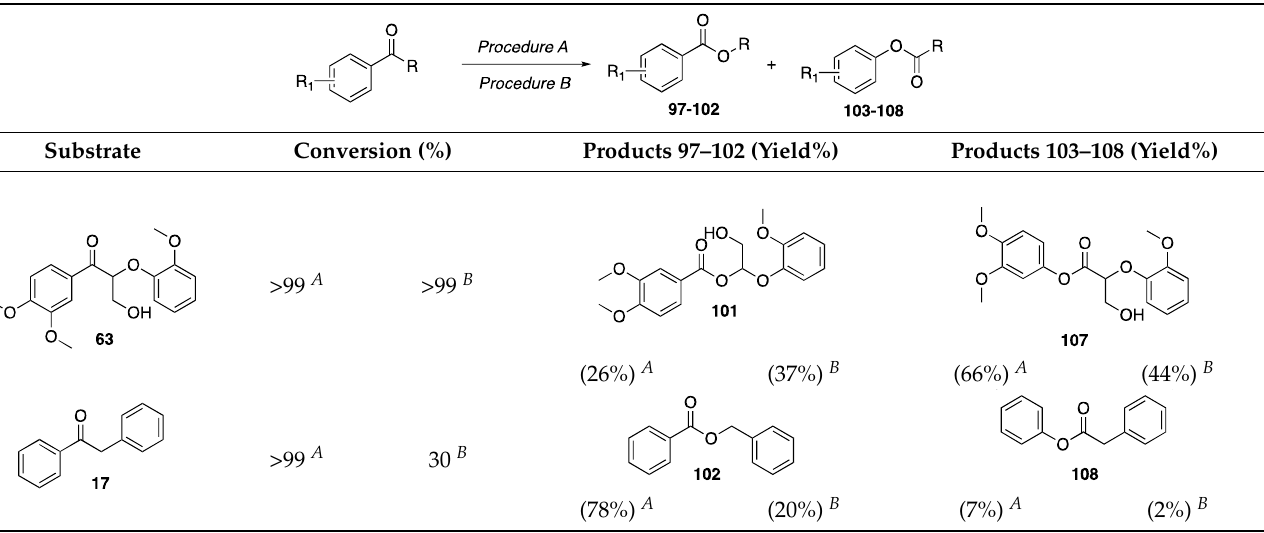
Table 5. BV oxidation of lignin model